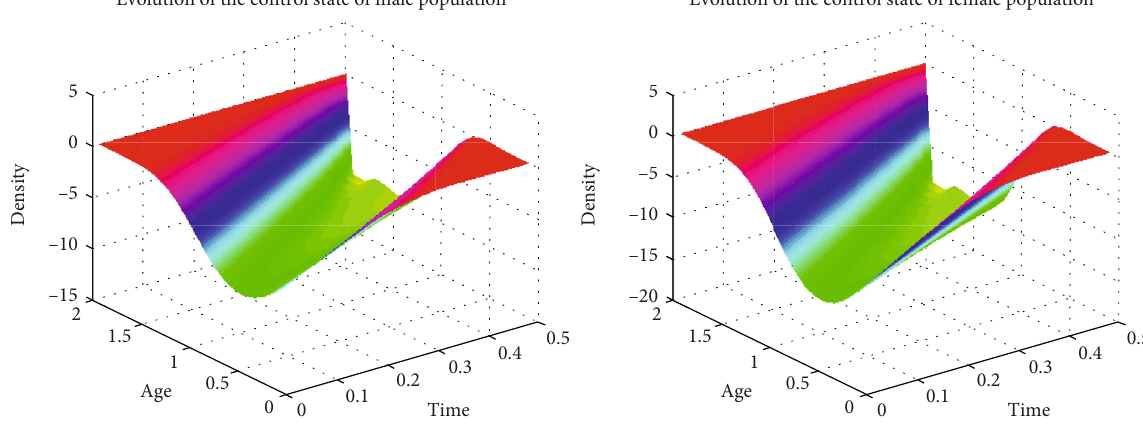
Figure 6: Evolution of the control states from a = t = 0 to A = 2 and t = 0 : 5